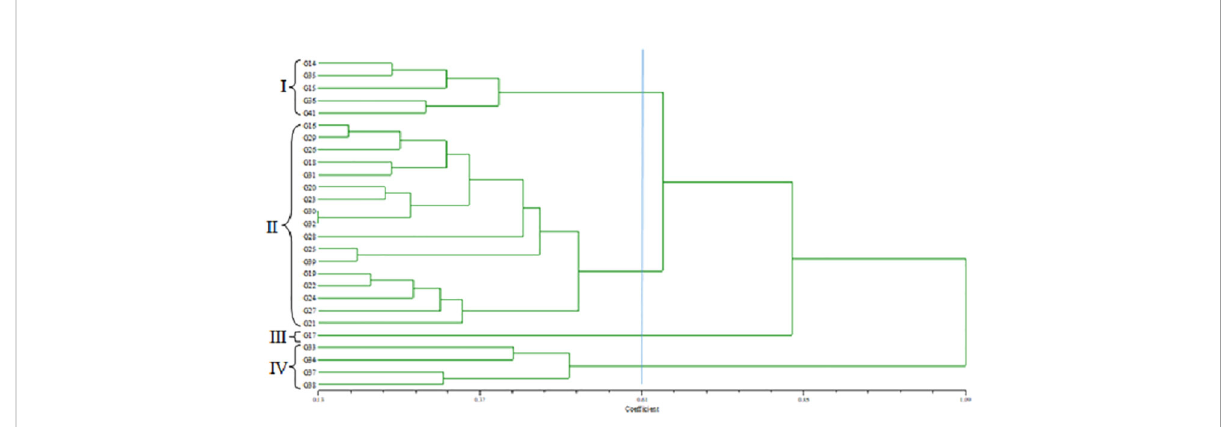
FIGURE 3 Dendrogram grouping the MR263-based